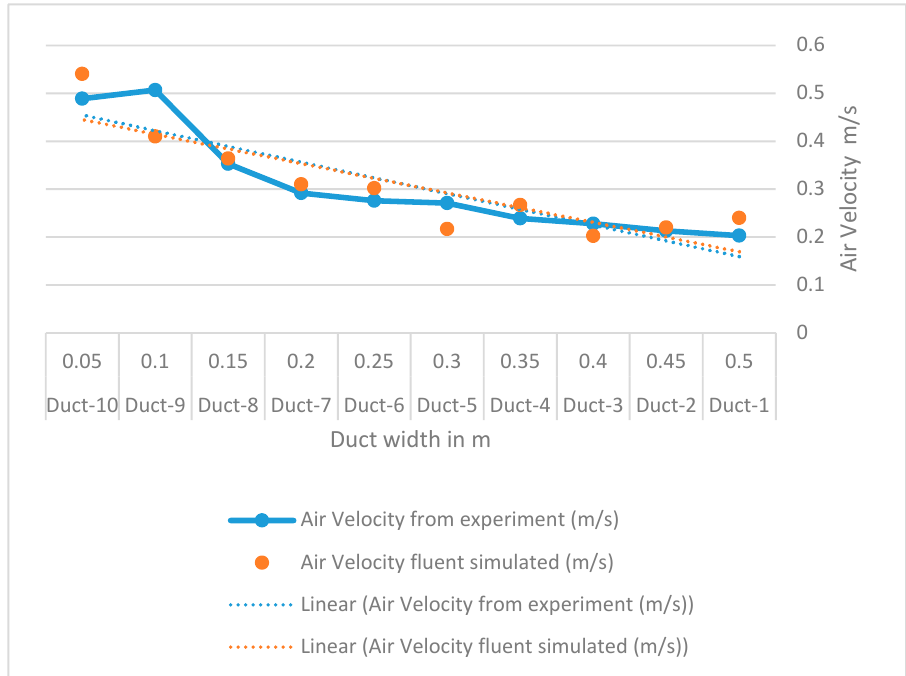
Figure 3. Comparison between the experimental and simulated results of velocity.